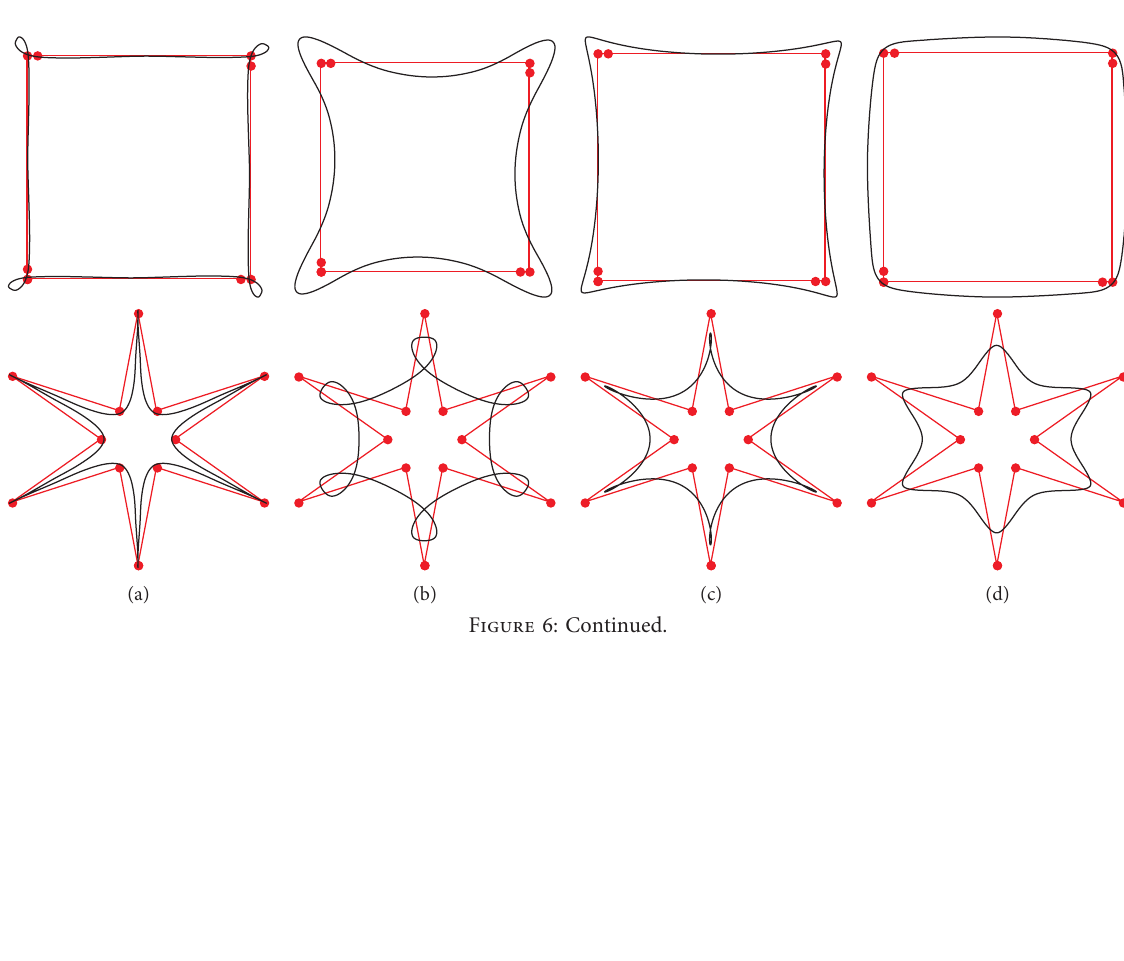
Figure 5: Black curves are the limit curves obtained by subdivision scheme S (a) α � 1/2048 , β � 255/4096; (b) α � 1/16 , β � − ( 1/30 ) ; (c) α � 1/8 , β � 0; (d) α � 1/4 , β � 1/4; (e) α � 1/32 , β � − 3/62; (f) α � 1/ 16 , β �